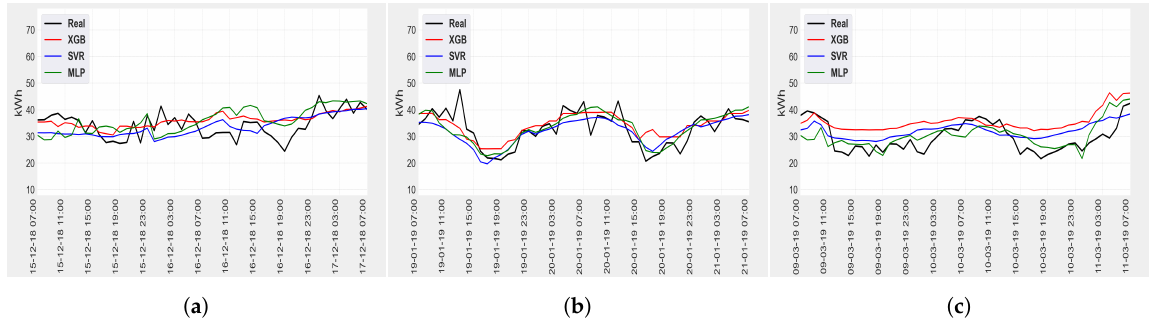
Figure 3. Results of thermal demand predictions in all samples studied: ( a ) Sample 1; ( b ) Sample 2; ( c ) Sample 3. Each machine learning model is represented by the prediction curve with the lowest CV(RMSE) among the 10 experiment